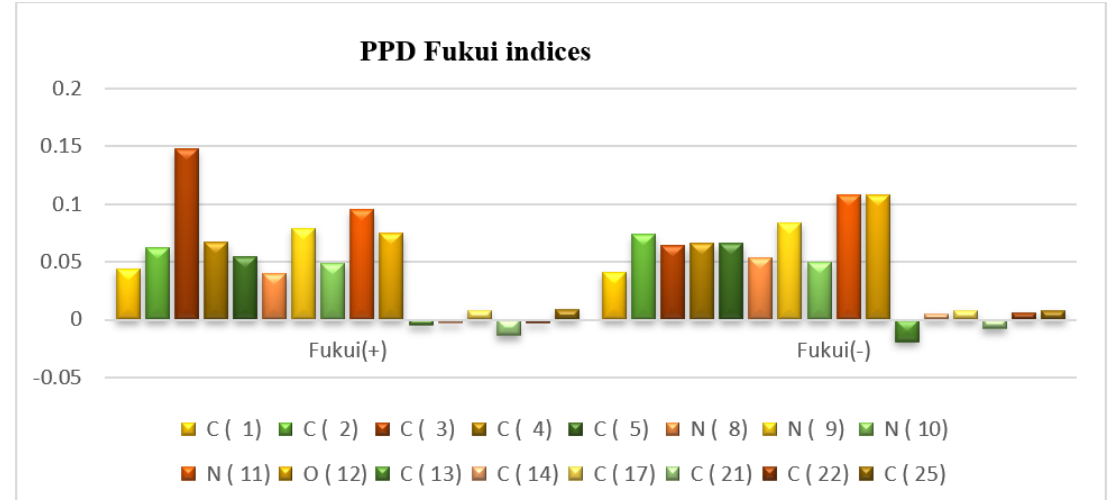
Figure 11. The Fukui function for nucleophilic attack Fukui (+) and electrophilic attack Fukui ( − ) for PPD.